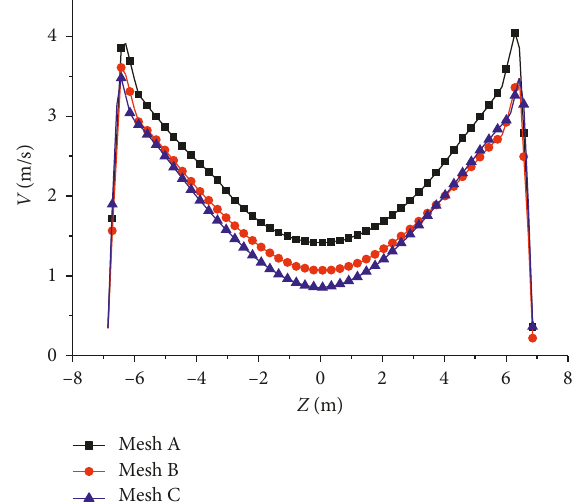
Figure 5: Velocity profiles at different positions at Z -axis for different mesh